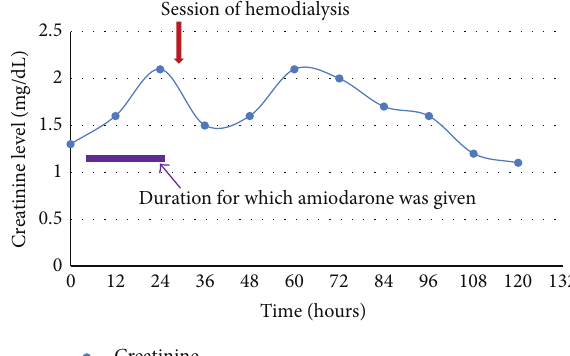
Figure 2: Worsening renal function after IV